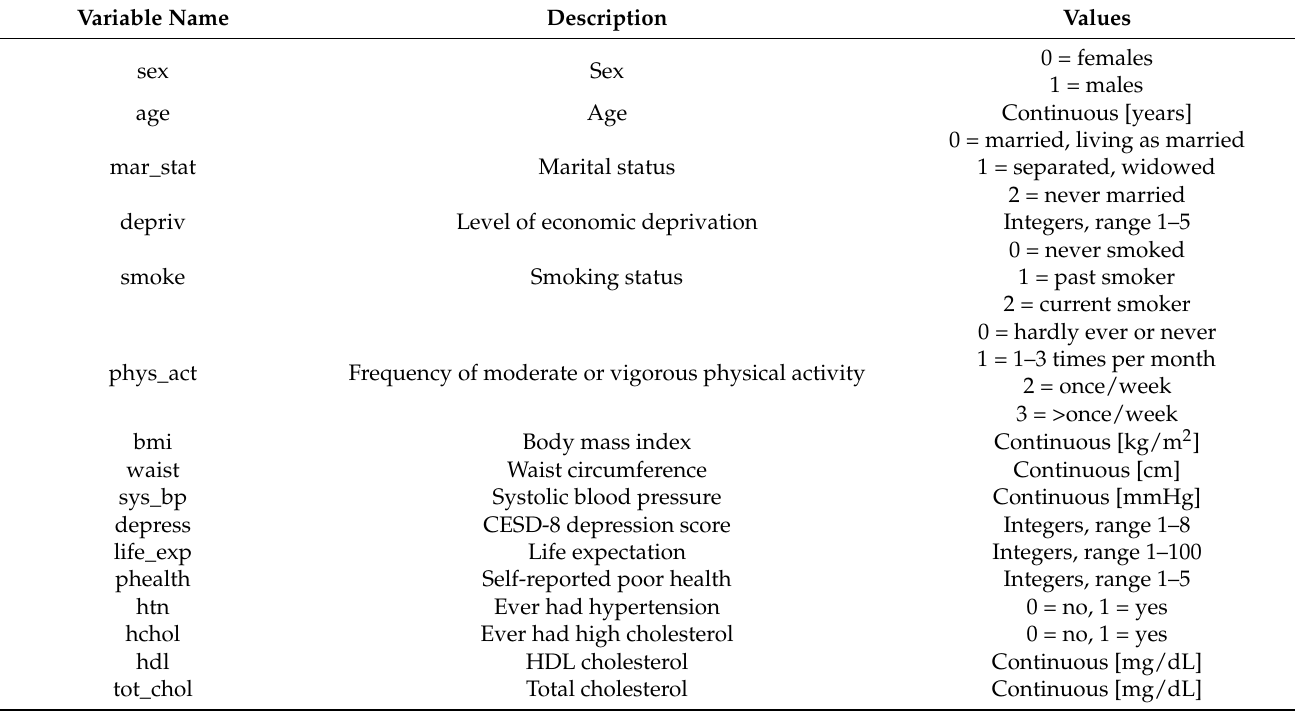
Table 3. Baseline variables selected as candidate predictors for T2D model